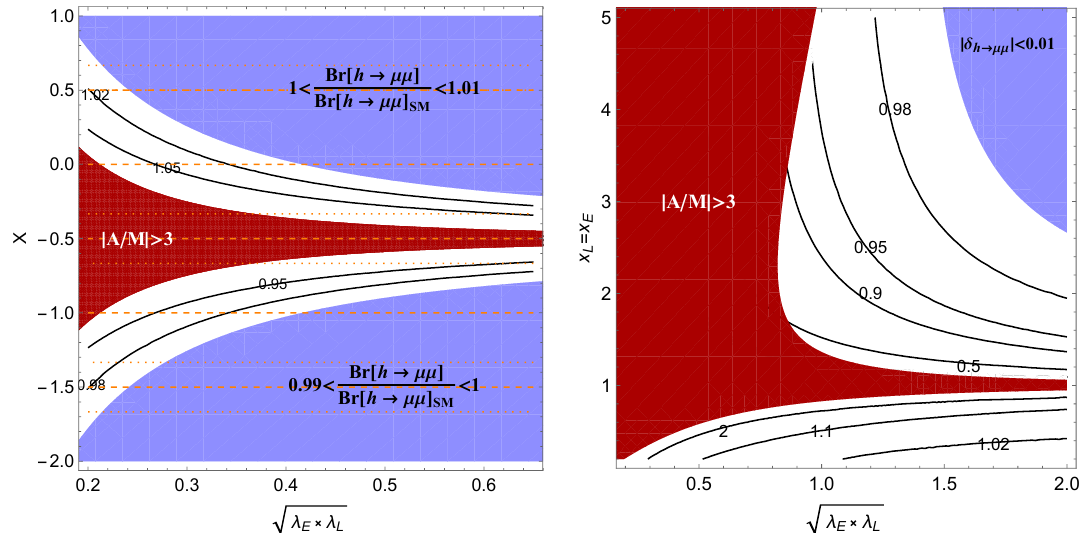
q λ I λ I and the L E /M 2 L,E Ψ